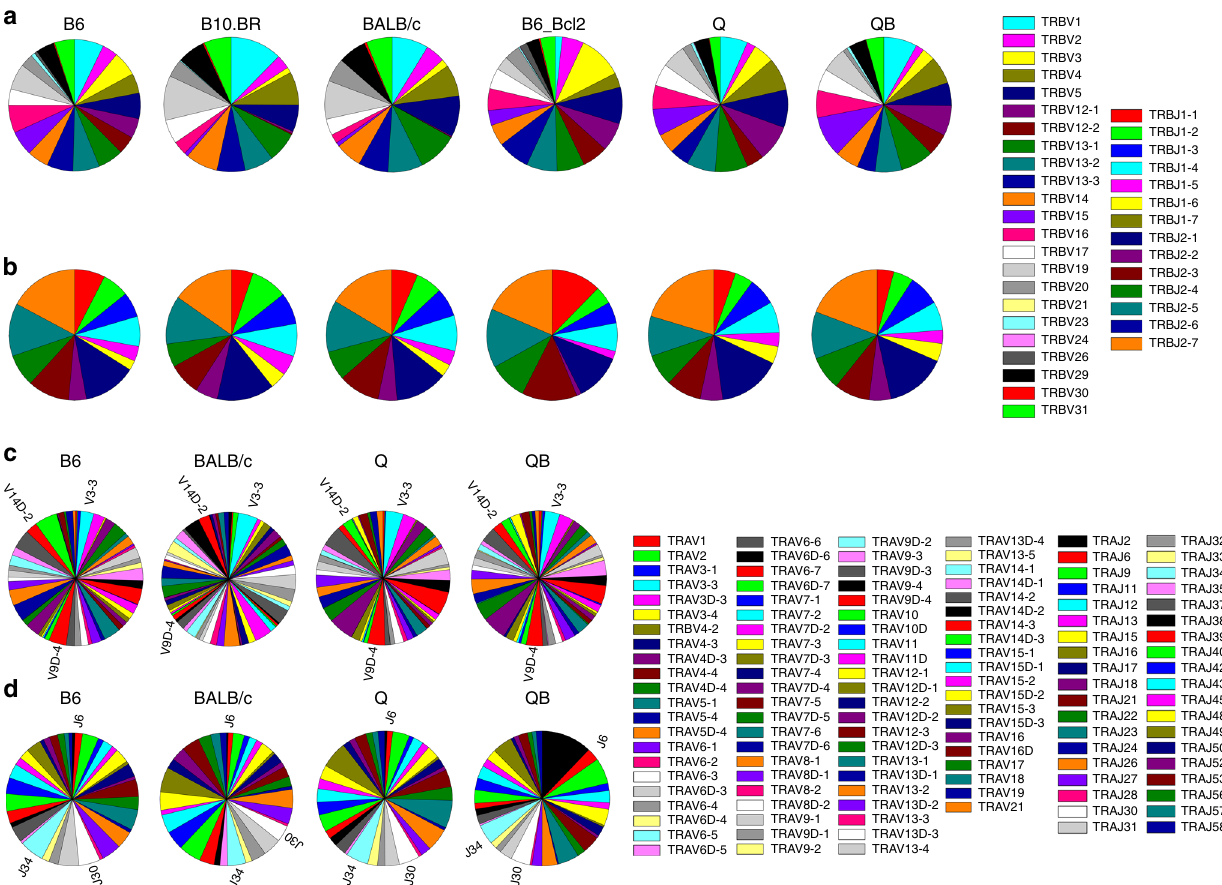
Fig. 6 V-gene and J-gene usage in various repertoires. a , b Representative V β gene ( a ) and J β gene ( b ) usage of MHCr, MHCi and pre-selection repertoires. c , d Representative V α gene ( c ) and J α gene ( d ) usage of MHCr and pre-selection